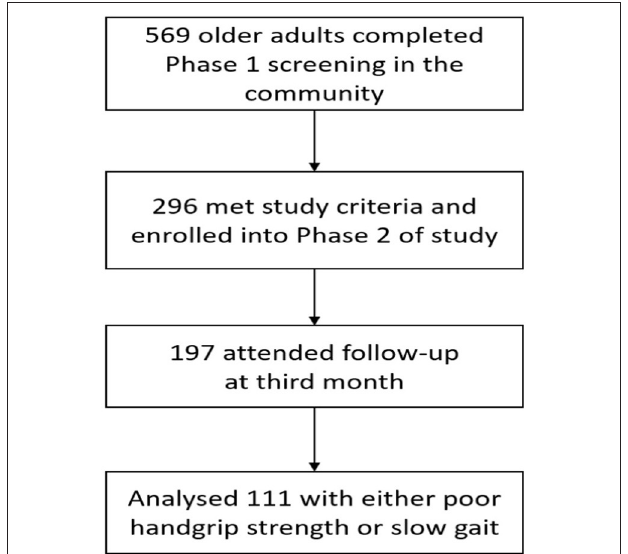
FIGURE 1 | Flow of participant recruitment.